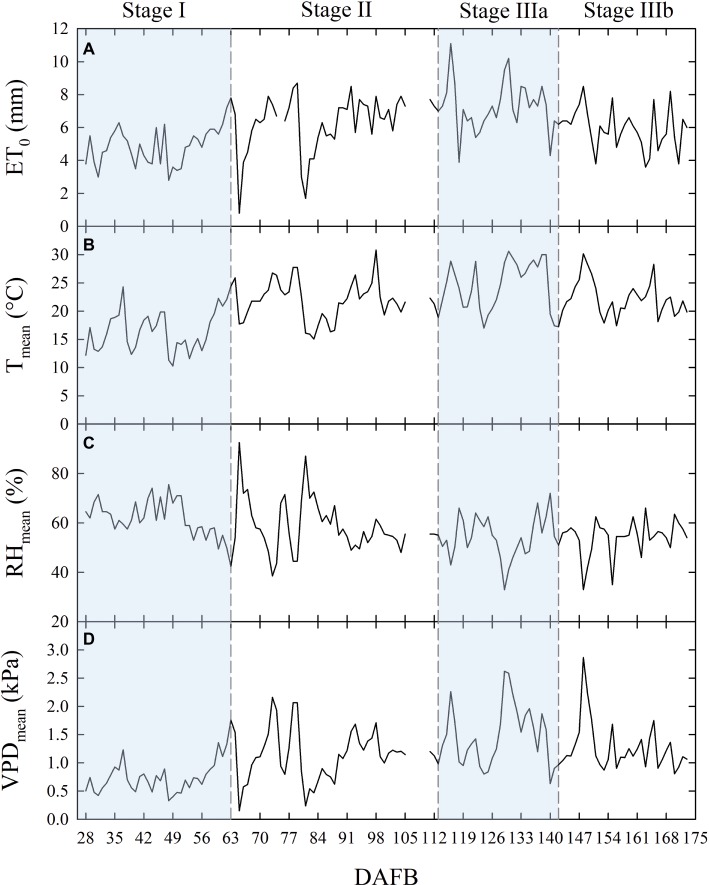
Daily total reference evapotranspiration [ET0
(A)], mean temperature [Tmean
(B)], mean relative humidity [RHmean
(C)], and mean vapor pressure deficit [VPDmean
(D)] along the considered four stages of fruit growth in days after full bloom (DAFB). Missing data from 106 to 110 DAFB.